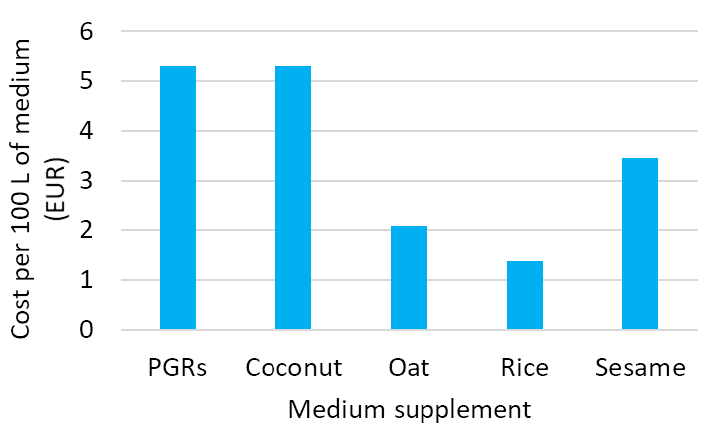
Figure 5. Comparison of costs (EUR) of conventional plant growth regulators (PGRs: BA and IBA) and natural additives used for the preparation of 100 L of multiplication medium.